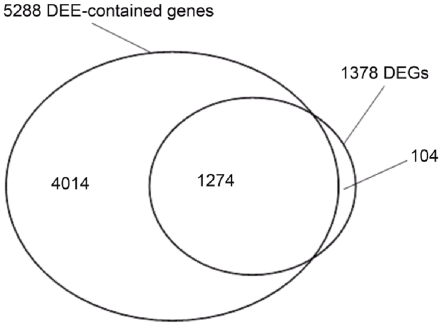
Venn diagram of intersection between 1378 DEGs and 5288 DEE-contained genes.